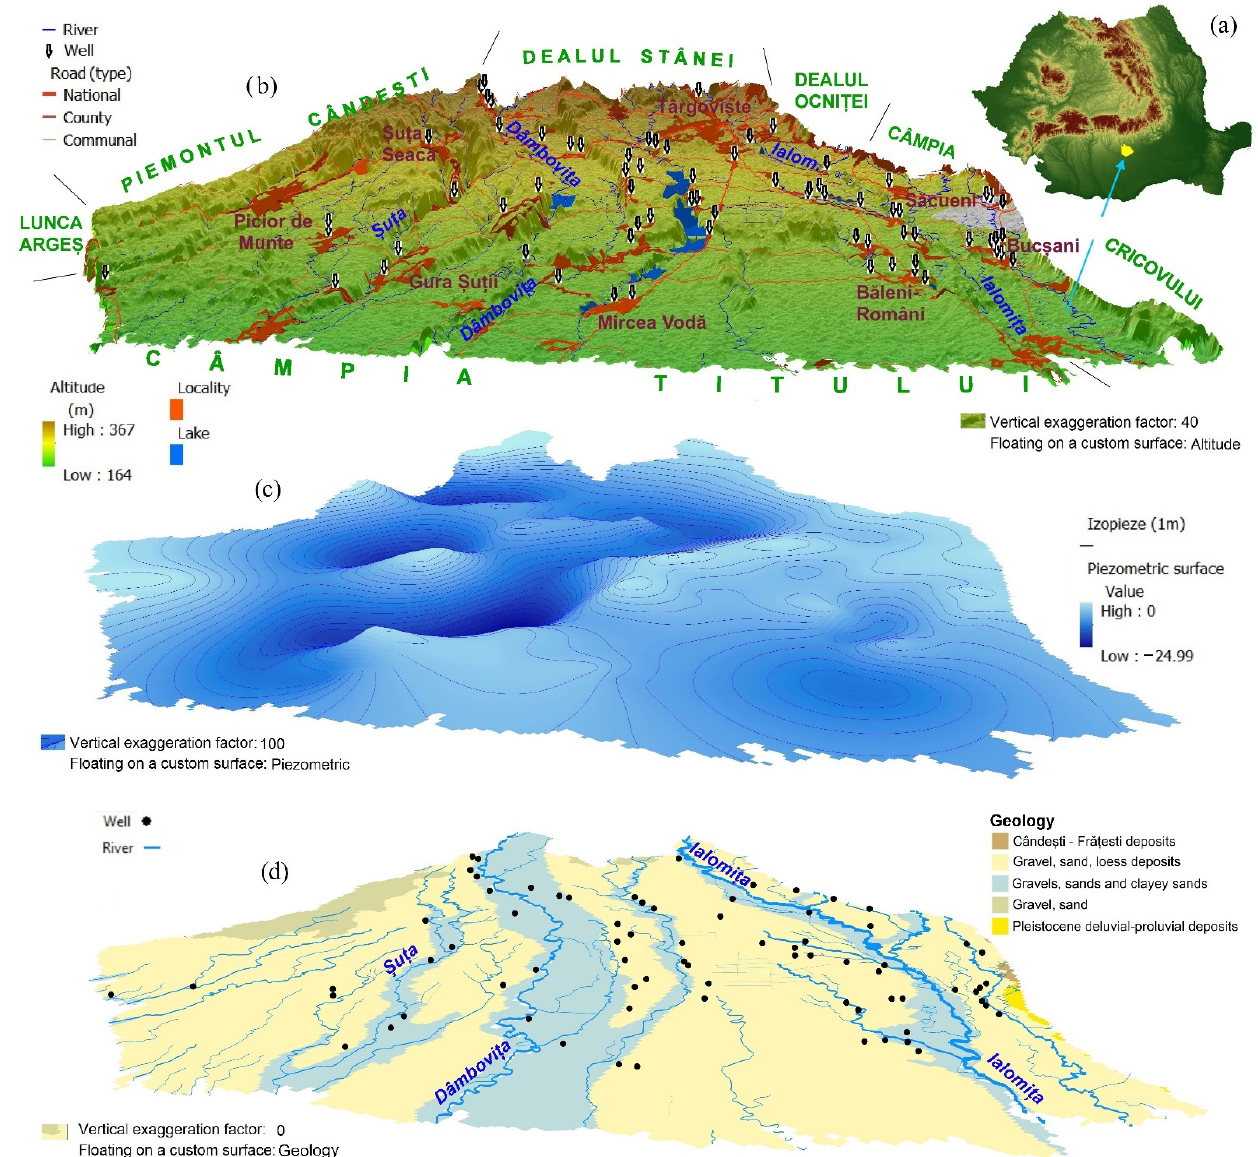
Figure 1. The geographical position of Târgovi ş te Plain in Romania ( a ), the 3D terrain model and sampled wells ( b ), the 3D model of the shallow groundwater ( c ) and geological map ( d ) (according to Topographic Map of Romania, 1978–1982).